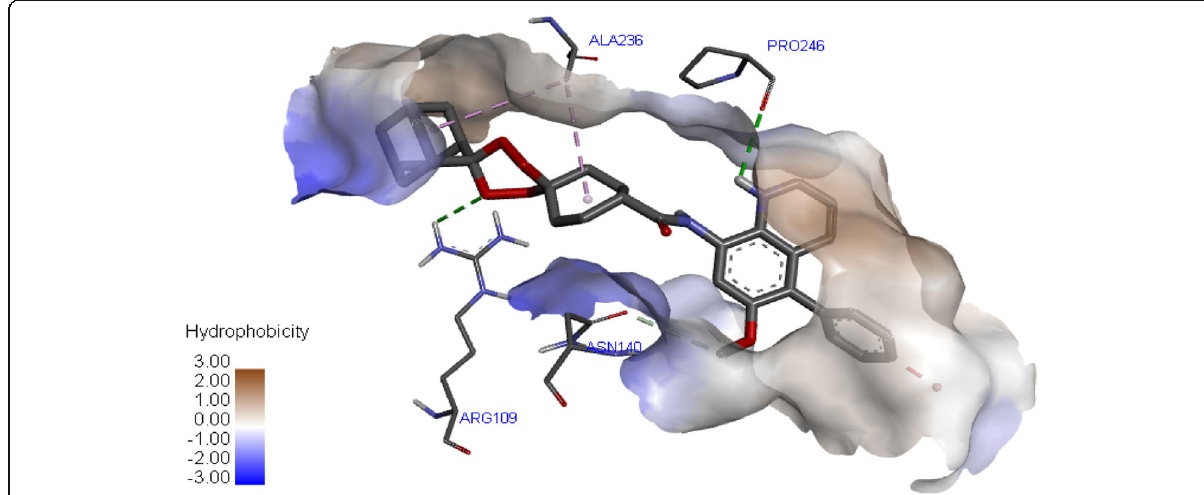
Fig. 6 Hydrophobic 22- pf LDH